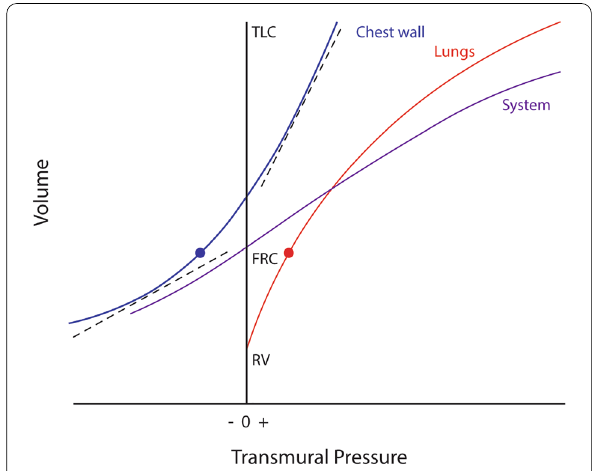
Fig. 1 Pressure–volume relationships of the respiratory